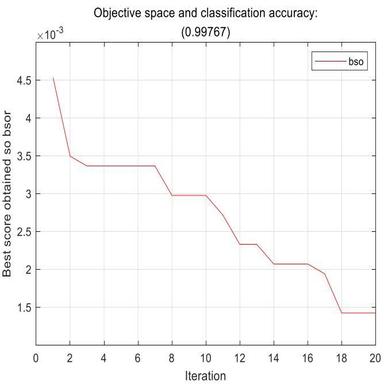
Brainstorming to optimize the classification recognition rate of neural networks.